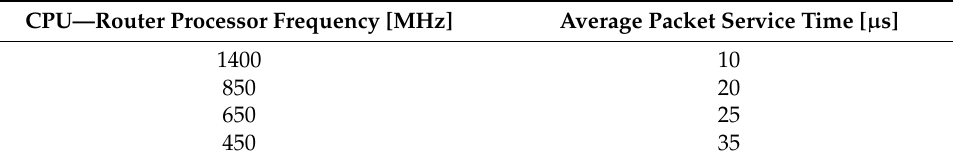
Table 1. Dependence of packet service time on router processor frequency.